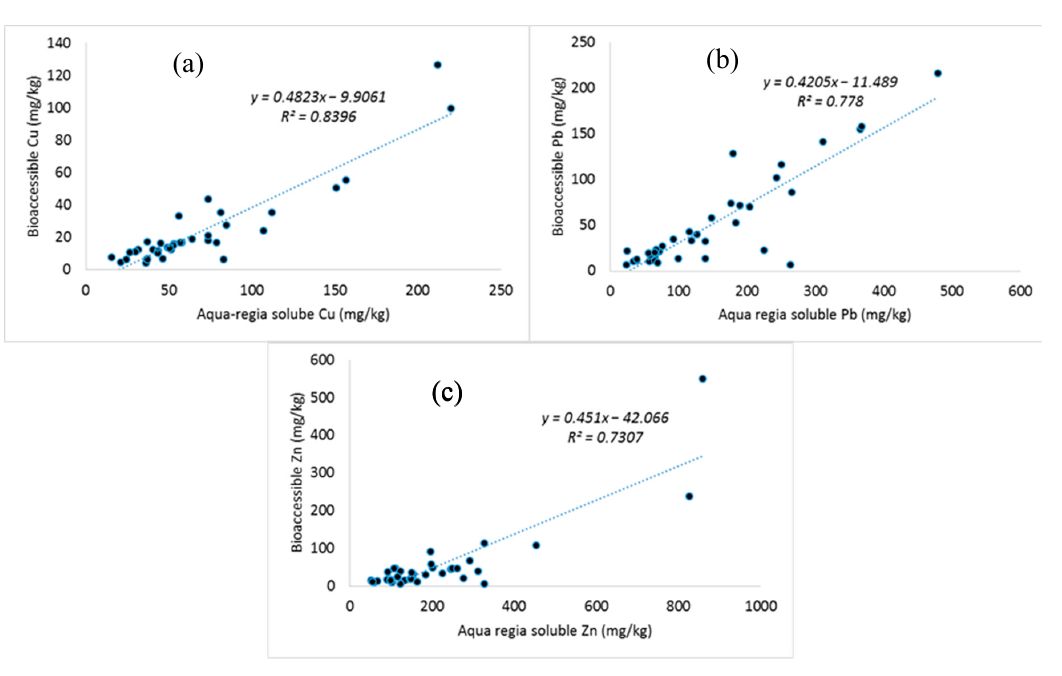
PBETG [14] Results are mean values ± 1 standard deviation, n = 37; nd—not determined; literature results are mean values except for those marked † which are median values; ‡ calculated from data presented in